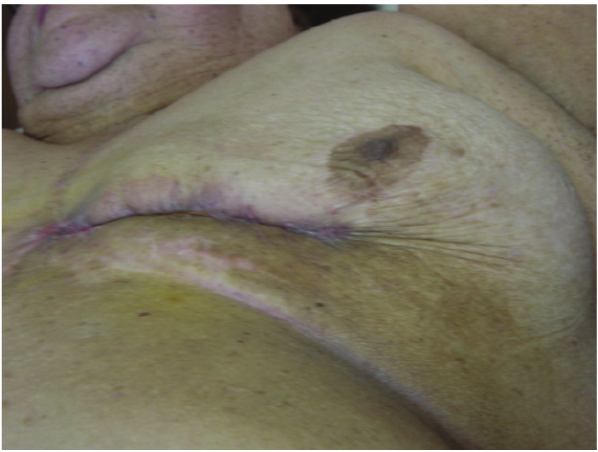
Figure 2 - Breast asymmetry 30 days after the second